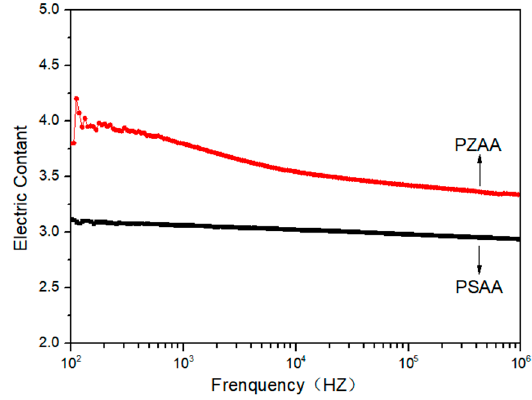
Figure 6. Frequency dependences of the dielectric constant of PSAA and PZAA.